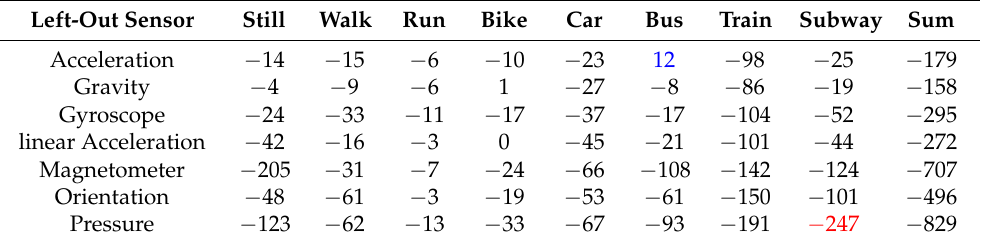
encoded last activations from the LSTM layers are shown in Figures 9–15. The color codes are blue for the class still , orange for the class walk , green for the class run , red for the class bike , violet for the class car , brown for the class bus , pink for the class train , and grey for the class subway